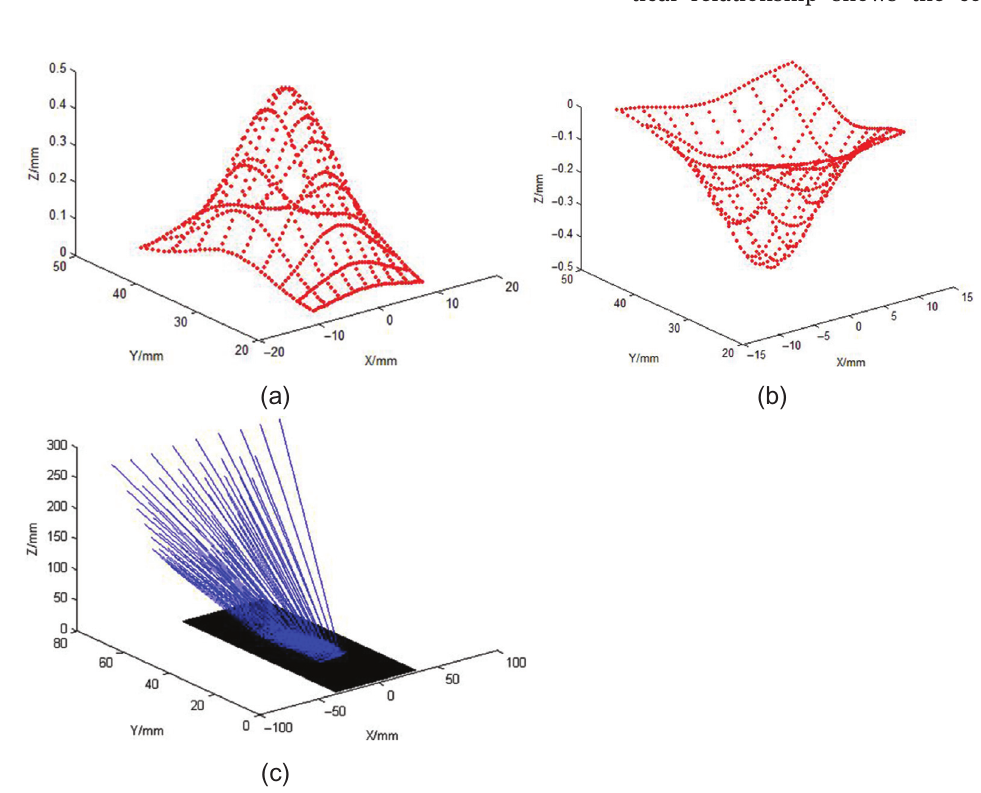
Figure 7: Simulation results for surface and incident rays at r = 5.8. (a) Convex. (b) Concave. (c) Incident